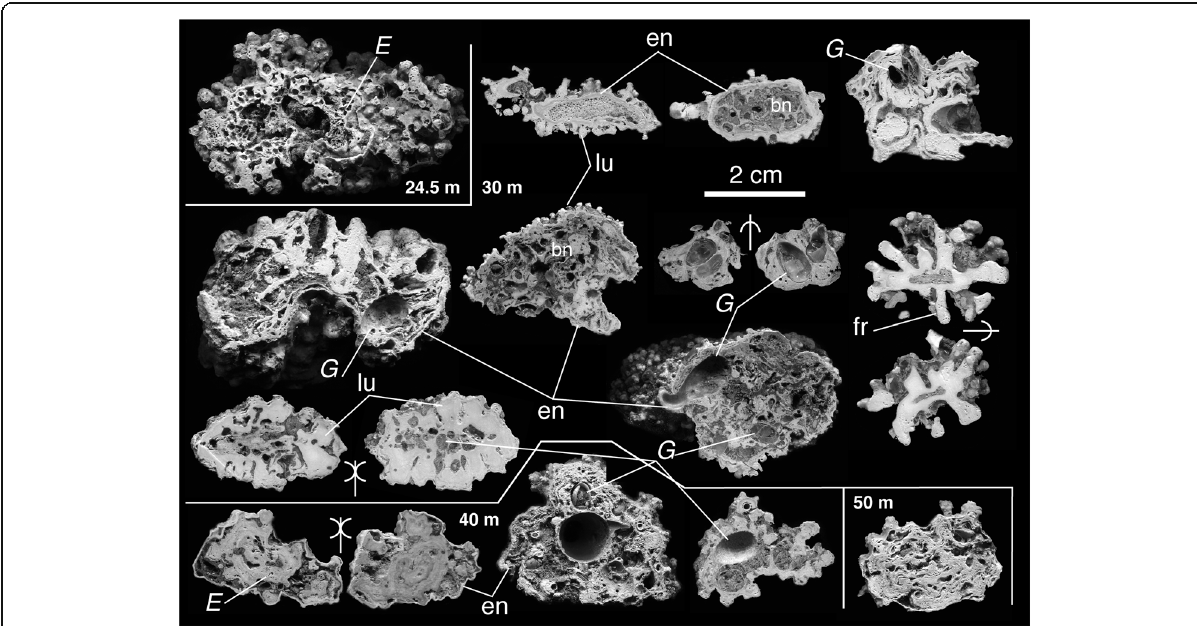
Fig. 5 Slab surfaces of rhodoliths from Cabo de Gata showing complex boring patterns and bioerosion traces from 24.5, 30, 40, and 50 m water depth. Symbol points out the split rhodoliths (see Fig. 6). E , Entobia ; G , Gastrochaenolites ; en, encrusting; lu, lumpy; fr, fruticose; bn, bioeroded nucleus